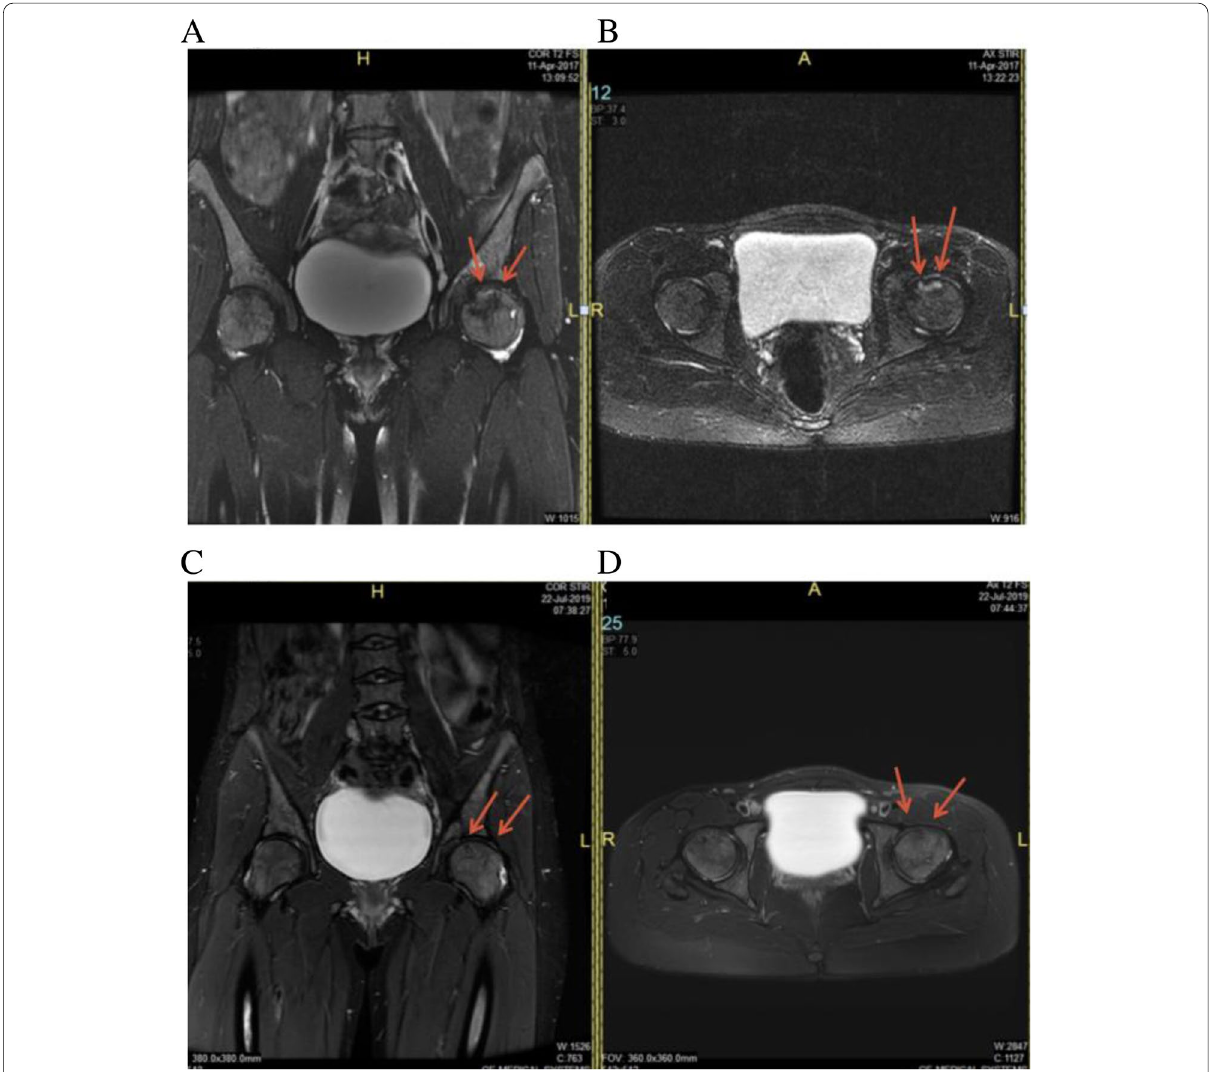
Fig. 1 A Coronal Short‑TI Inversion Recovery image and B Axial T2 weighted fat suppressed image of the left hip demonstrates a geographic subchondral area of ANFH in the anterior‑superior aspect of the left femoral head. There is no significant subchondral collapse of the femoral head articular surface. C Coronal Short‑TI Inversion Recovery image and D Axial T2 weighted fat suppressed image of the left hip performed 2 years after demonstrates near complete resolution of the femoral head